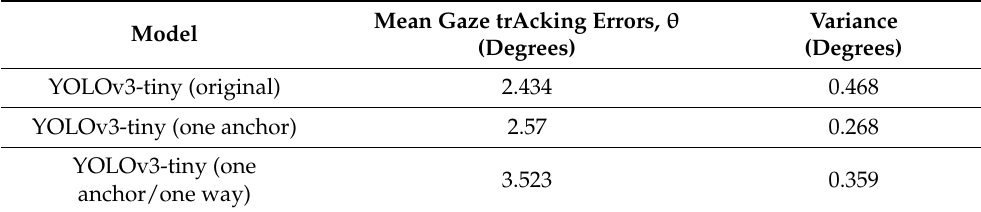
Table 9. Comparisons of gaze tracking errors among the three YOLOv3-tiny-based models for the testing